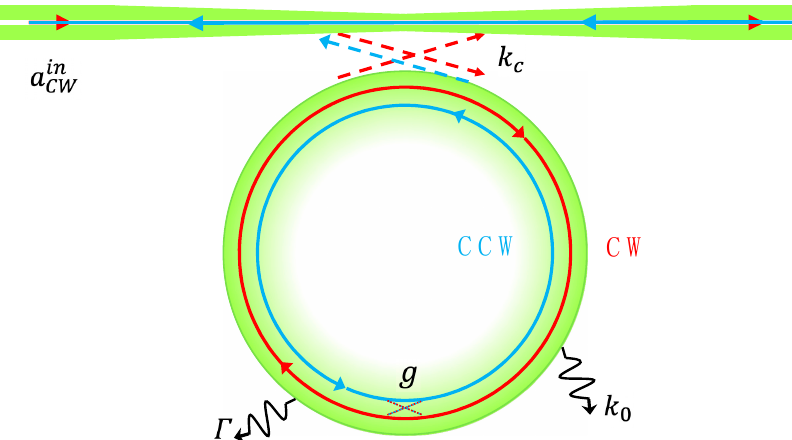
Figure 1. Sketch of the fiber-resonator coupled system, where k 0 is the intrinsic damping rate, k c is the microresonator-taper coupling rate, Γ is the additional damping rate because of scattering loss and g is the coupling coefficient of the light scattered into the resonator. a in is the clockwise (CW) input field in the fiber taper.